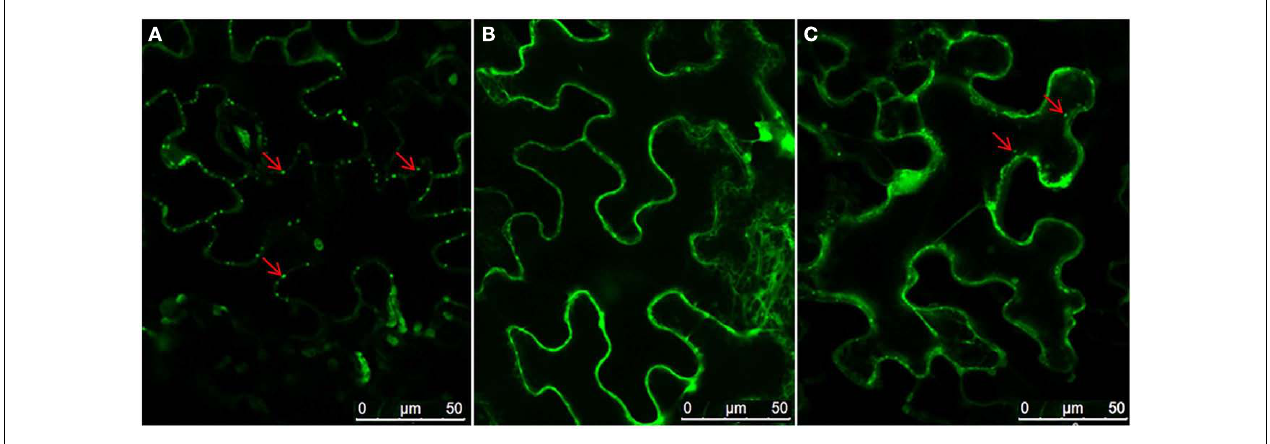
expression of NSvc4-eGFP.The leaf shown in (C) was agroinfiltrated with deletion mutant of NSvc4 (NSvc4 106–125 -eGFP). Arrows indicate the localization of fusion protein.